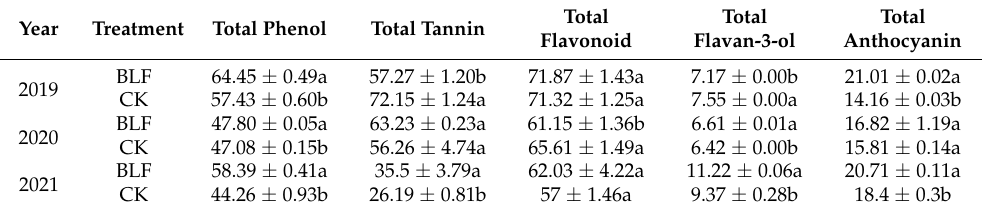
Table 2. Concentrations (mg/g, mean ± standard deviation) of polyphenols in ‘Cabernet sauvignon’ grape skins from BLF and CK treatments in 2019, 2020, and 2021.